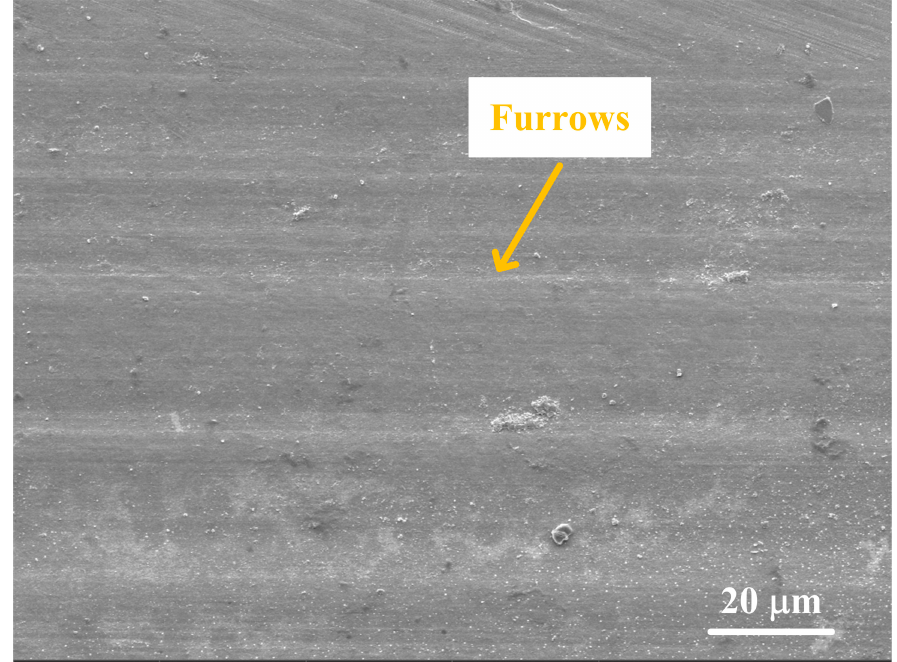
Figure 14. Wear morphology of the coating.